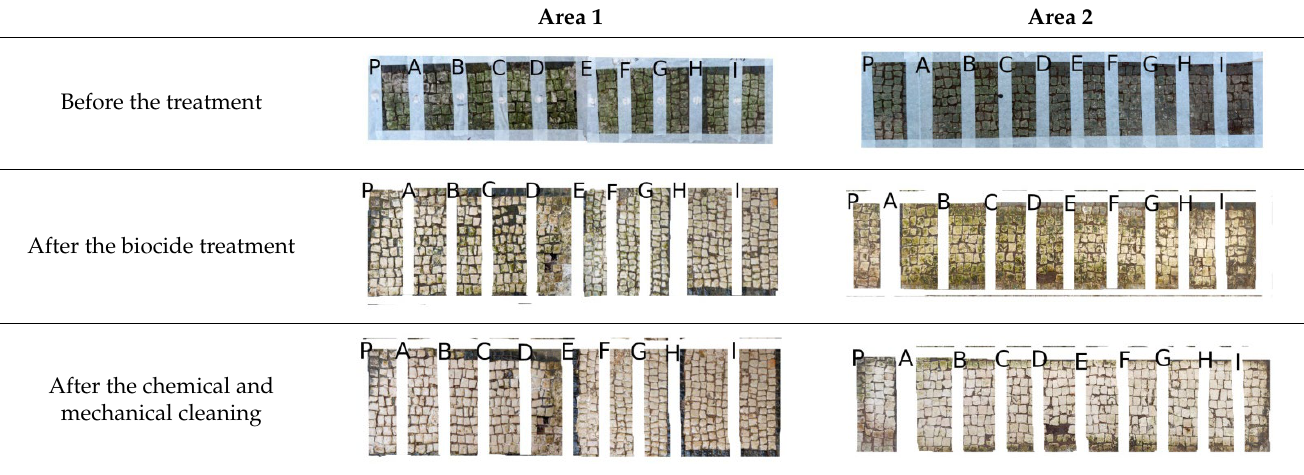
Table 3. Images of Areas 1 and 2 before, after the treatment with Eos, and after the cleaning pro- cedure.